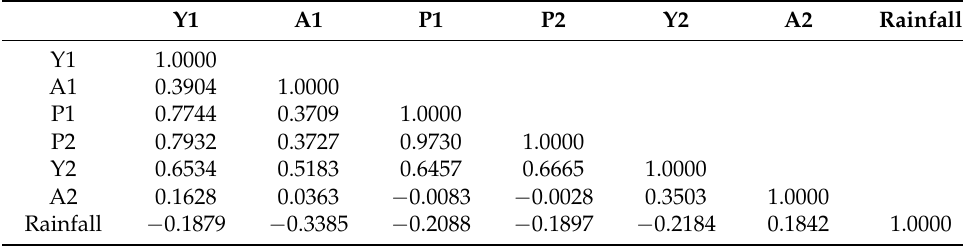
Table 2. Correlation matrix.